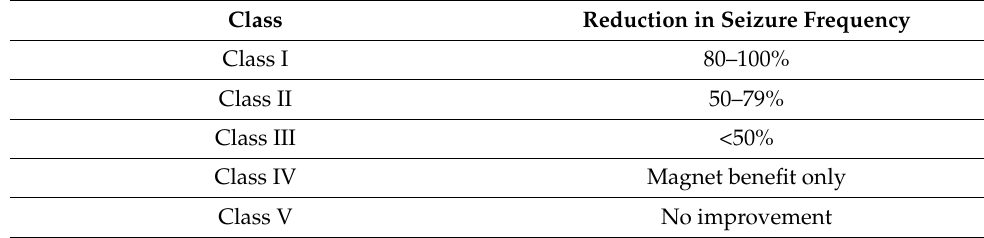
Table 2. Modified McHugh